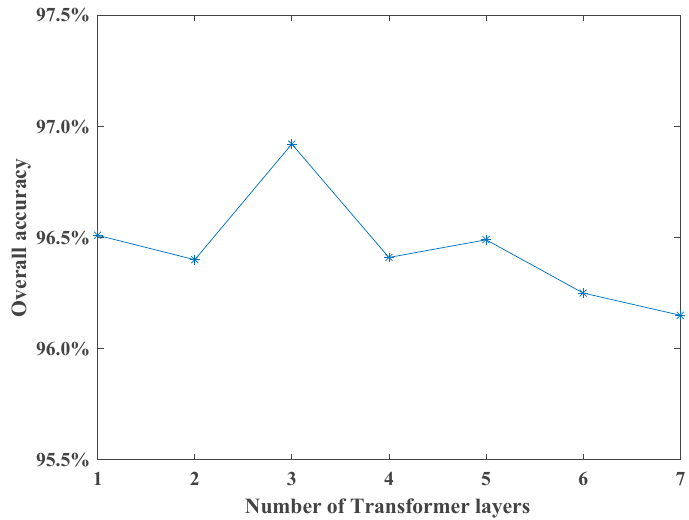
Figure 6. Effect of the number of transformer layers on classification results.